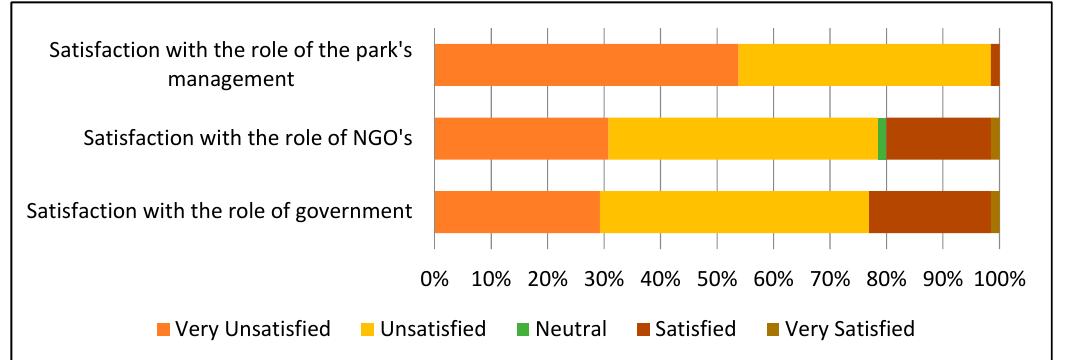
Figure 5. Household satisfaction ratings for Non-Governmental Organizations (NGOs), the Government of Cameroon (GoC), and the management of the KNP in developing the KNP (n = 65).